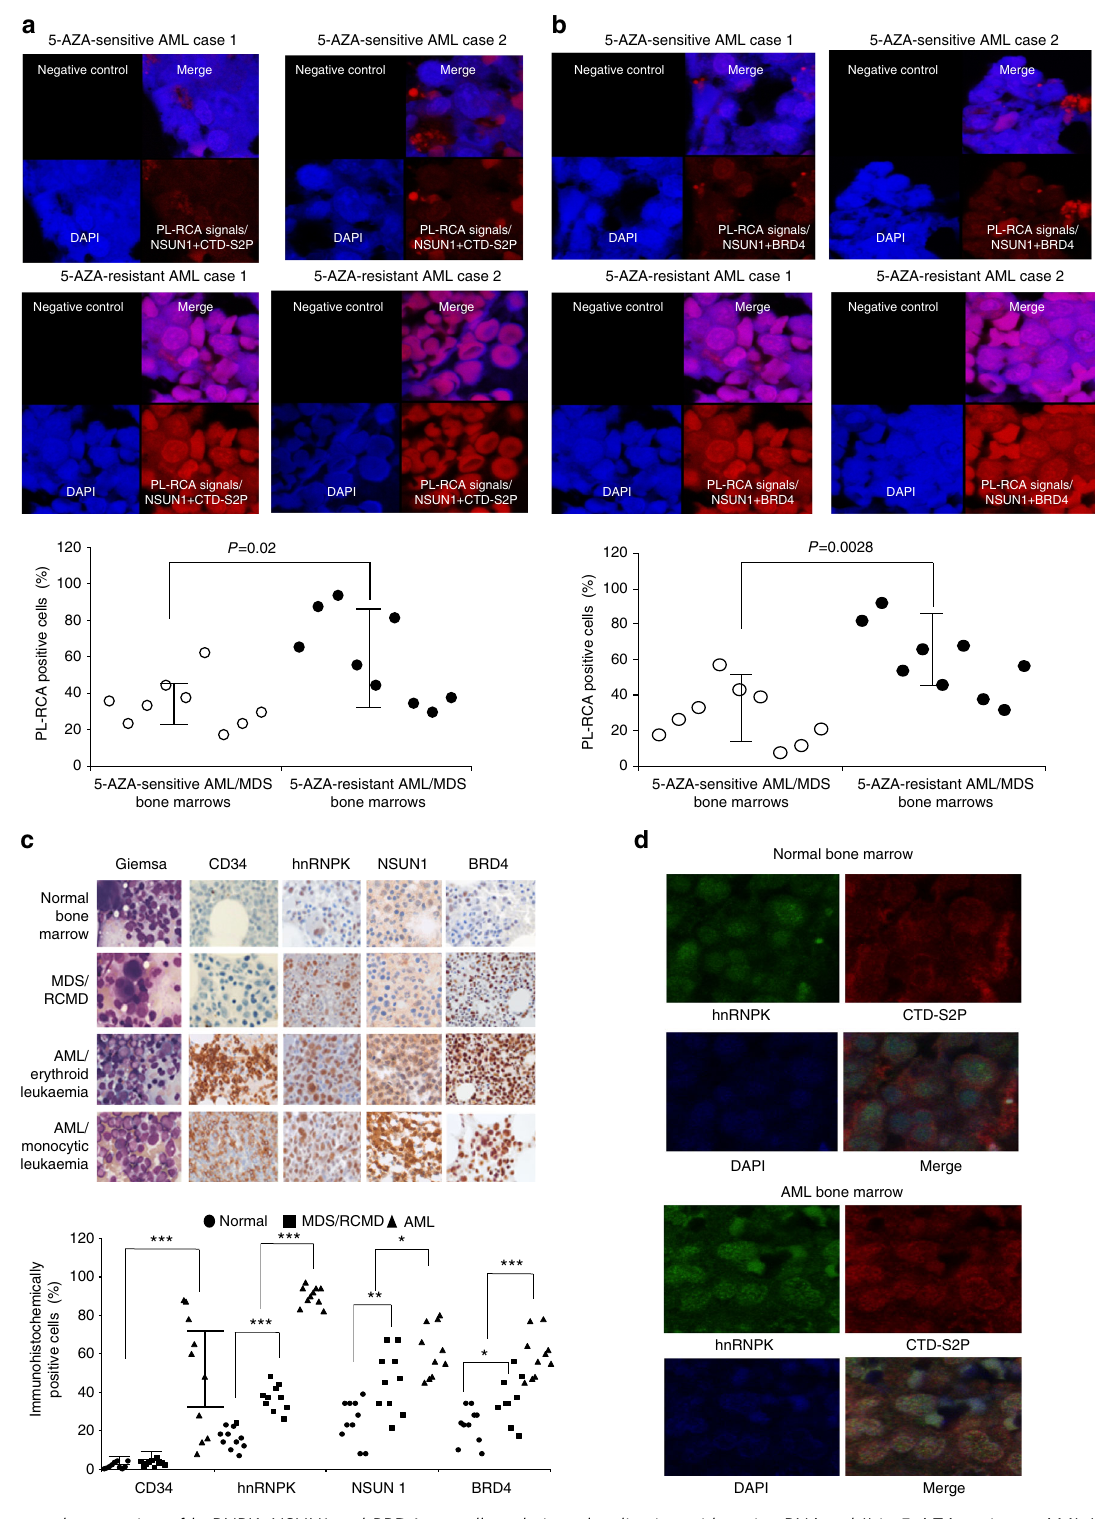
Fig. 10 Increased expression of hnRNPK, NSUN1 and BRD4 as well as their co-localization with active RNA-pol-II in 5-AZA-resistant AML/MDS specimens. a Visualization and quantitative measurement of co-localization of NSUN1 and RNA-pol-II CTD-S2P in 5-AZA-sensitive and 5-AZA-resistant clinical AML/MDS bone marrow specimens by PL-RCA. b Visualization and quantitative measurement of co-localization of NSUN1 and BRD4 in 5-AZA- sensitive and 5-AZA-resistant clinical AML/MDS bone marrow specimens by PL-RCA. c Morphological and immunohistochemical studies of the expression of CD34, hnRNPK, NSUN1 and BRD4 in the bone marrow cells from normal controls, cytogenetically normal MDS/refractory cytopenia with multilineage dysplasia (RCMD), and AML, n = 10 for each group, with an Olympus BX43 microscope at ×400 magni fi cation. d STED confocal microscopic analysis of the expression and subcellular localization of hnRNPK and RNA-pol-II CTD-S2P in normal and AML bone